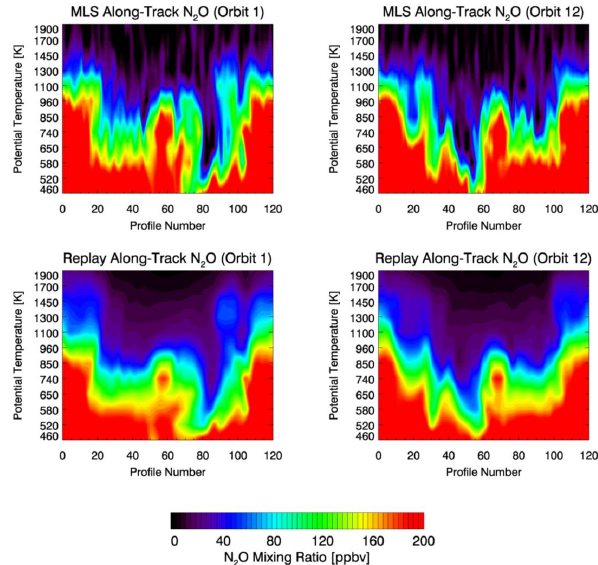
Fig. 6. MLS and Replay curtain plots (along-track cross-section Figure 6. MLS and Replay curtain plots (along-track cross-section as function of pressure 2 as function of pressure and profile number) for the two orbits from and profile number) for the two orbits from 28 March 2005 (see Figure 5). Red (blue) 3 28 March 2005 (see Fig. 5). Red (blue) indicates high (low) N 2 O indicates high (low) N 2 O values. 4